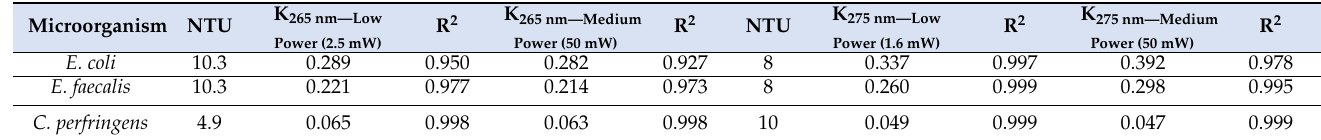
Figure 6. Inactivation rate constant, K(cm 2 /mJ) vs. microorganisms and wavelengths. Table 5. Inactivation rates for the different bacteria and